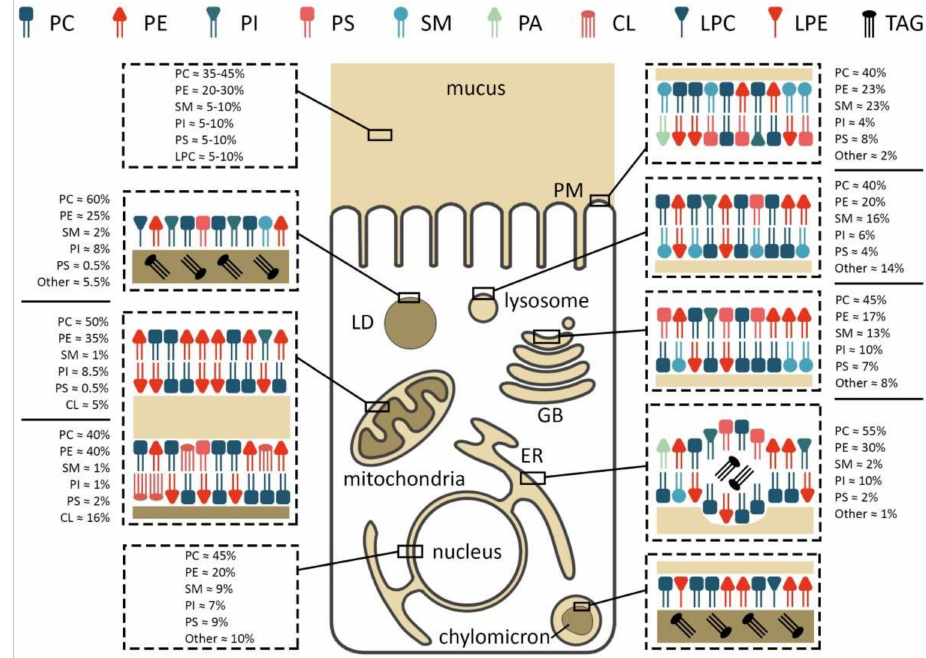
Figure 2. Membrane composition and localization of major phospholipids in an enterocyte. PC/PE/PS/PI—phosphatidyl- choline/-ethanolamine/-serine/-inositol, LPC/E—lysophosphatidylcholine/-ethanolamine, TAG—triacylglycerol, SM—sphingomyelin, CL—cardiolipin, PM—plasma membrane, LD—lipid droplet, GB—Golgi body, ER—endoplas- mic reticulum.